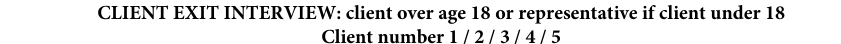
Table 2. An exit interview tool used during the Star Rating Assessment of 2017/18 in